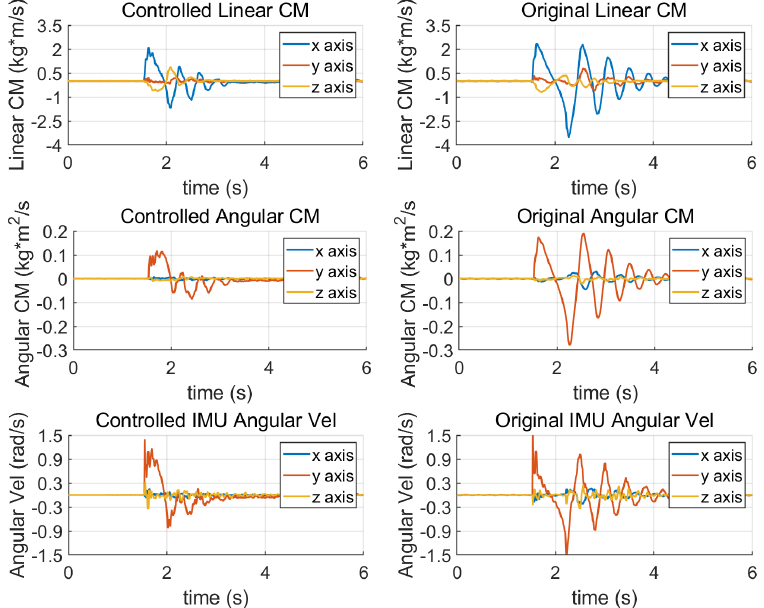
Figure 9. The linear and angular momentum change of standing balancing. Both the linear and angular momentum are decreased after the allocation control. The maximum angular velocity of the torso is also reduced because of the rapid stabilization